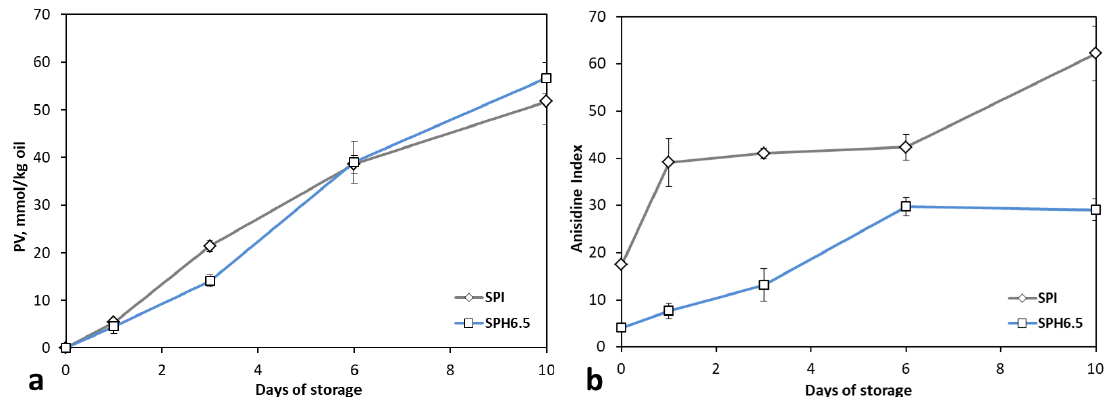
Figure 5. Evolution of ( a ) peroxide value (mmol / kg oil) and ( b ) anisidine index for the optimal (SPH6.5) and control (SPI) emulsions.